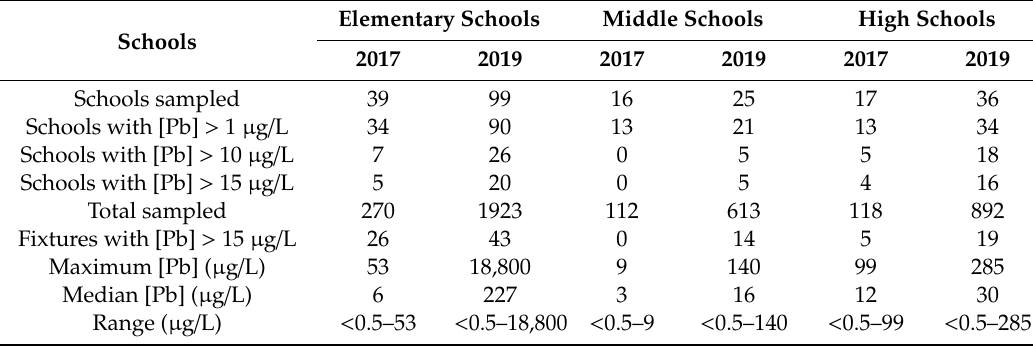
Table 1. Lead Concentration ([Pb]) in Water for a School District in Tennessee.